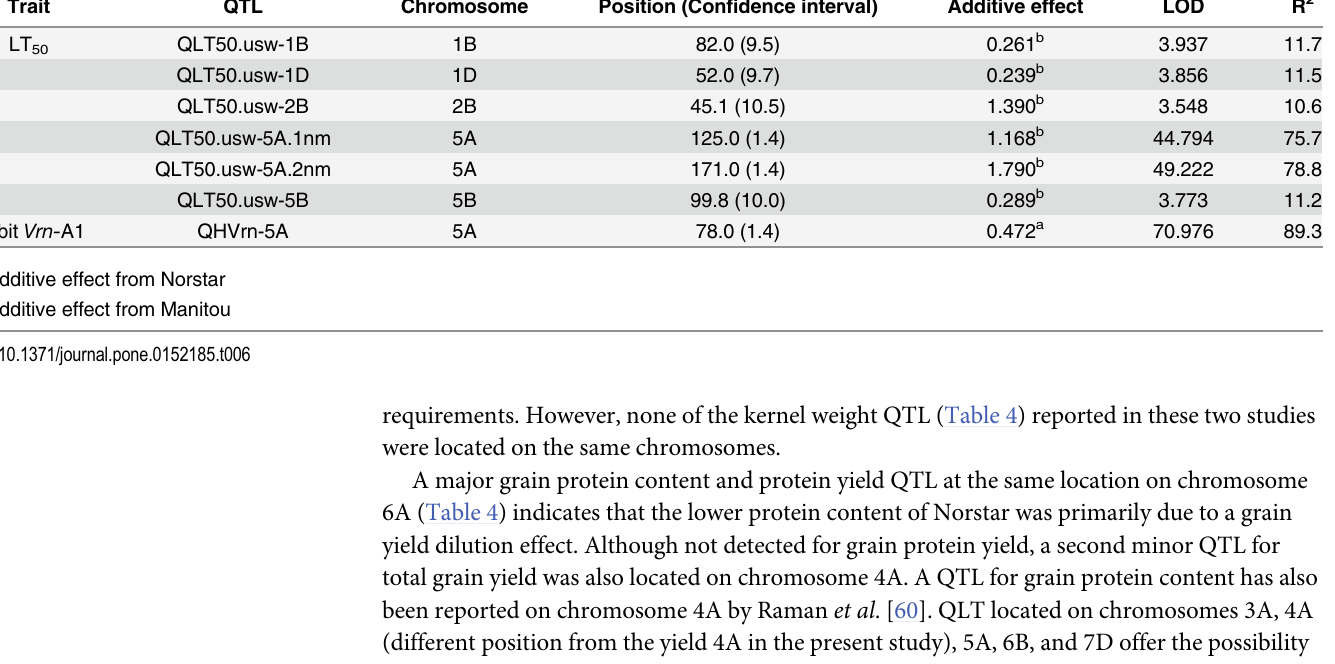
Table 6. QTL of Norstar x Manitou detected in controlled Environment Trials. Position (cM) is given at the peak of LOD with the confidence interval (cM). Additive effect is given according to the parent, Norstar (a) and Manitou (b). Trait